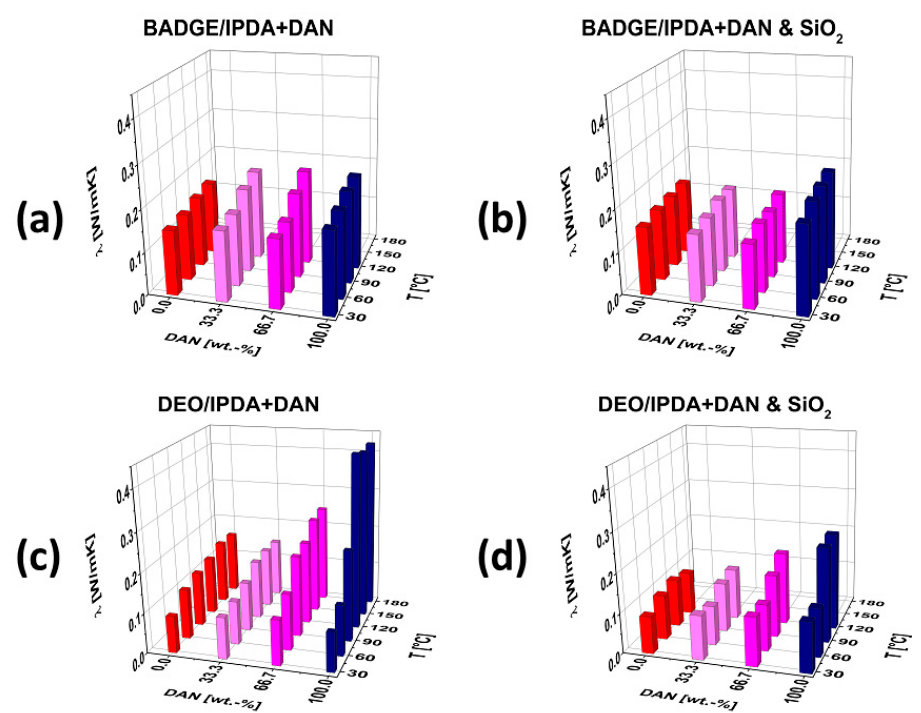
Polymers 2021 , 13 , x FOR PEER REVIEW 8 of 12